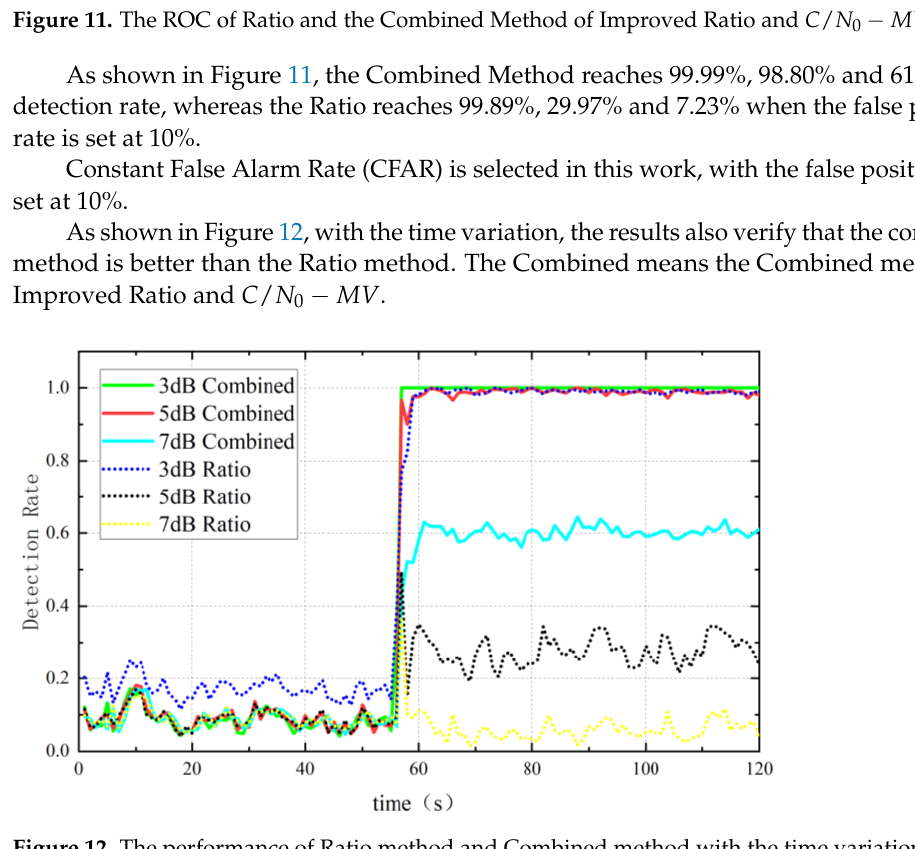
Figure 12. The performance of Ratio method and Combined method with the time variation.